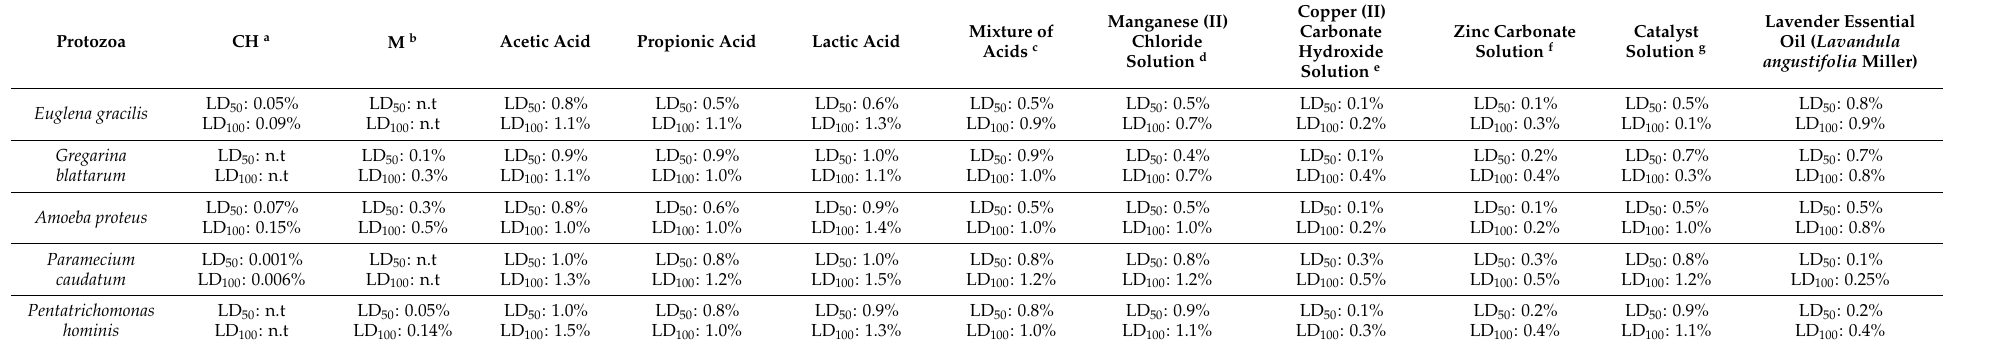
Table 8. LD 50 , LD 100 values of lavender essential oil ( Lavandula angustifolia Miller) and the components used in the